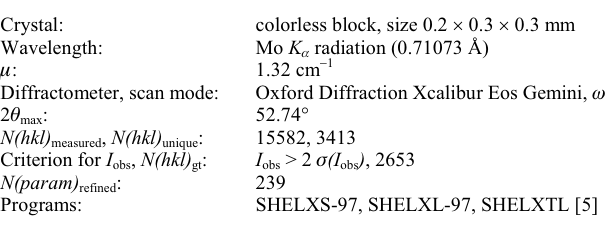
Table 1. Data collection and handling.